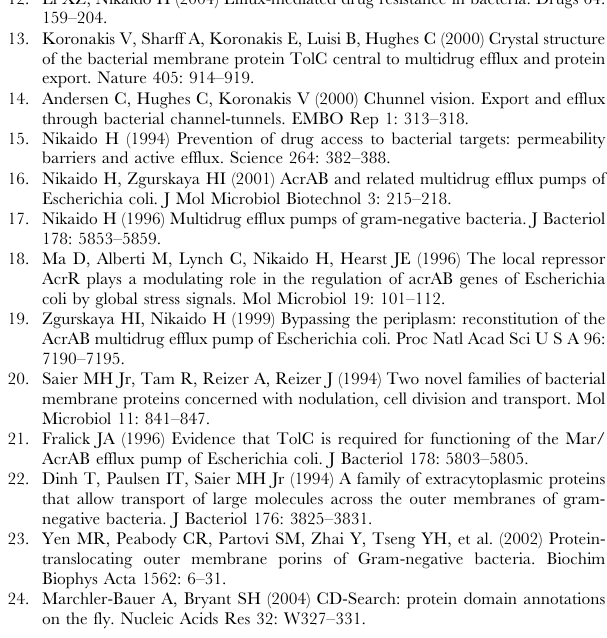
Figure S1 Outer membrane proteins of B. burgdorferi B31-A D p66::str were separated by anion exchange chromatography. Fractions showing uniform channel-forming activity with a single- channel conductance of about 300 pS were precipitated, separated by SDS-PAGE and silver stained.